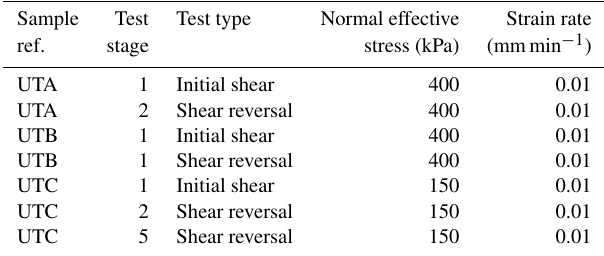
Table 1. Summary of monotonic drained shear test experiment pa-